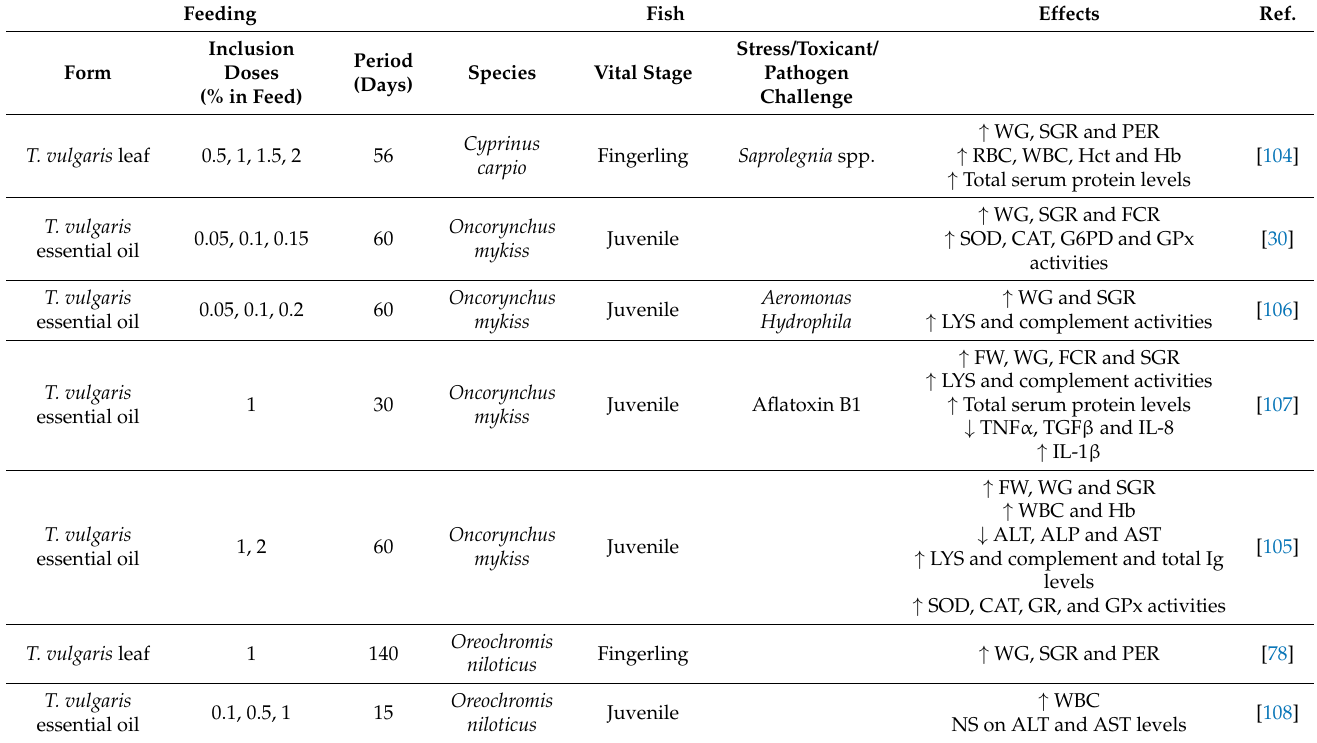
Table 4. Studies of thyme products added to the feed of aquaculture